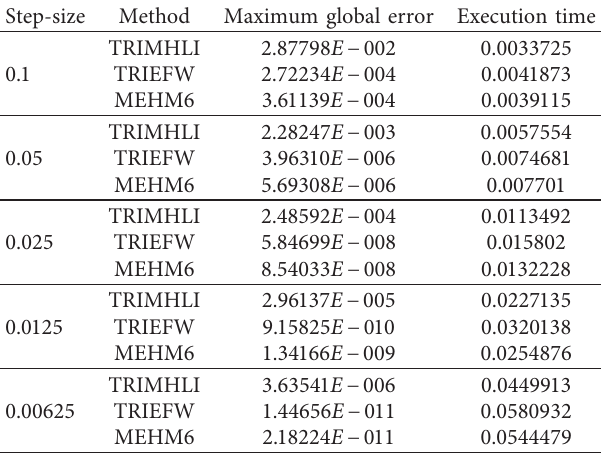
Table 2: Numerical results for Problem 2.